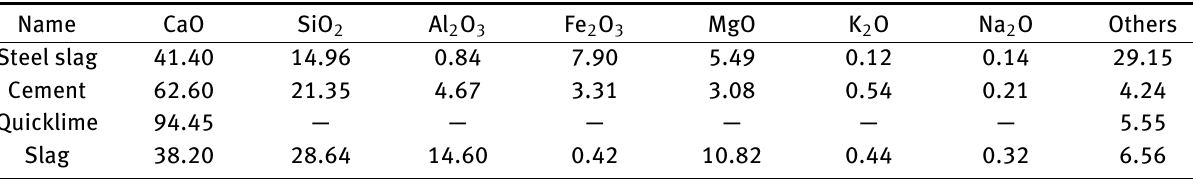
Table 1: Chemical compositions of the raw materials (wt%) Name Steel slag